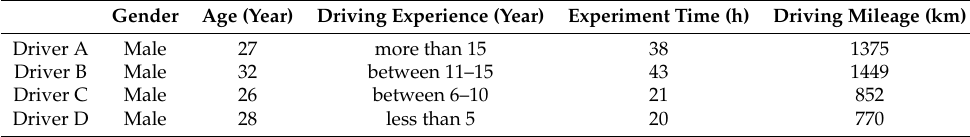
Table 2. Detailed information of participated drivers.